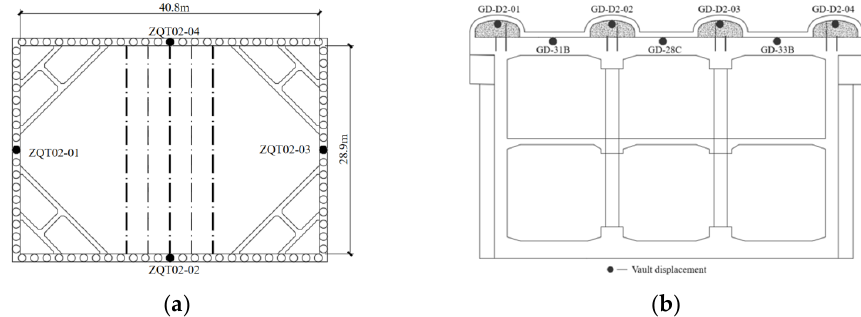
Figure 18. Layout of measuring points. ( a ) Measuring points of foundation pit retaining structure; ( b ) section survey points of existing stations at section A-A.